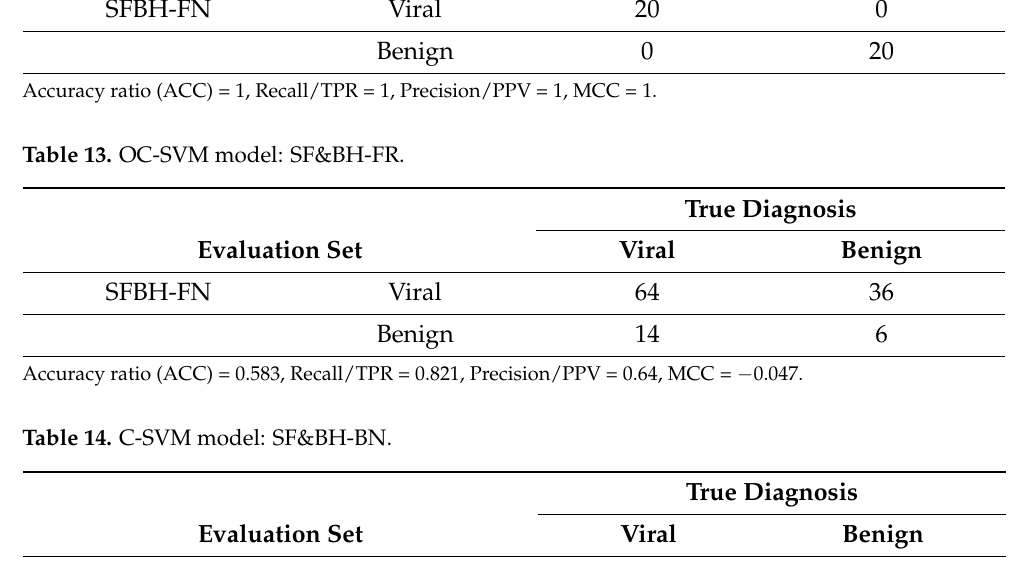
Table 12. C-SVM model: SF&BH-FR. True Diagnosis Evaluation Set Viral Benign SFBH-FN Viral 20 0 Benign 0 20